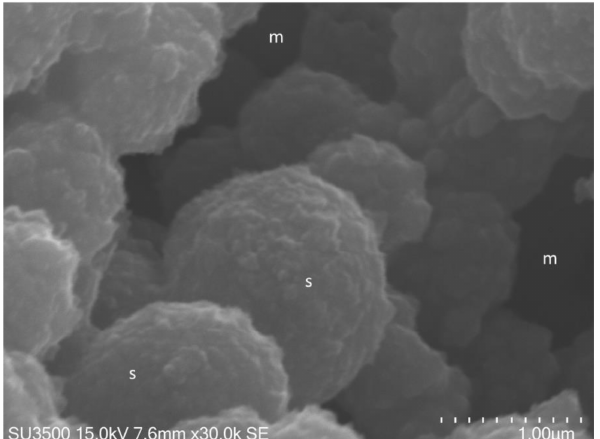
Figure 8. S. mutans prepared by the OsO 4 -RR-TA-IL procedure. At high magnification, 30,000 × , and high voltage, 15 kV, a globular Eps formed trabeculae of a microcanalicular system, m, and lines the bacterial cells’ surface, s. This high magnification and high-resolution image confirms the value of this protocol in terms of biofilm three-dimensional structure preservation up to the nanometric